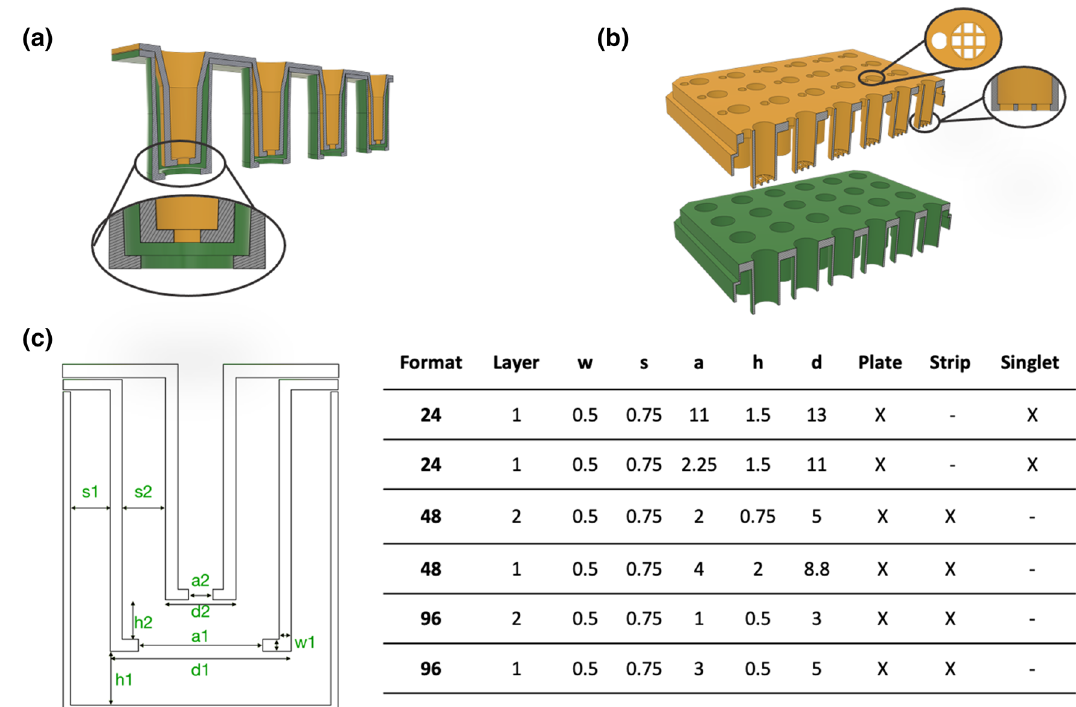
Figure 1. Representative illustrations of 3D-printed inserts. ( a ) Stacked (layering) insert approach. ( b ) 24-Well format insert plates. (c ) Dimensions of introduced 3D-printed inserts and representative examples of singlet, strip, and plate format inserts in the online library ( w width, s distance between layer walls, a aperture, h height from the well/insert below, d diameter; all dimensions in PTFE membrane was placed on the bottom and secured with a ring slipped over the bottom of the insert. The ring was pressing the filter towards the sides of the insert. The excess resin was absorbed in the filters on the sides of the inserts rather than the bottom, which minimized the blockage of the filter in the aperture (Supplementary Fig. S1a-top right panel). The PTFE membrane could not be removed without destroying it (data not shown), which indicated a tight seal.